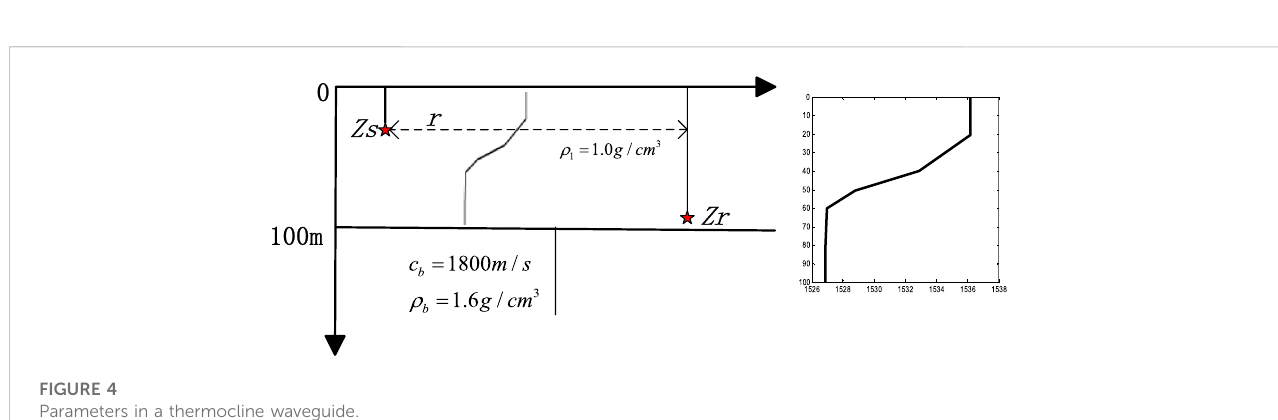
FIGURE 4 Parameters in a thermocline